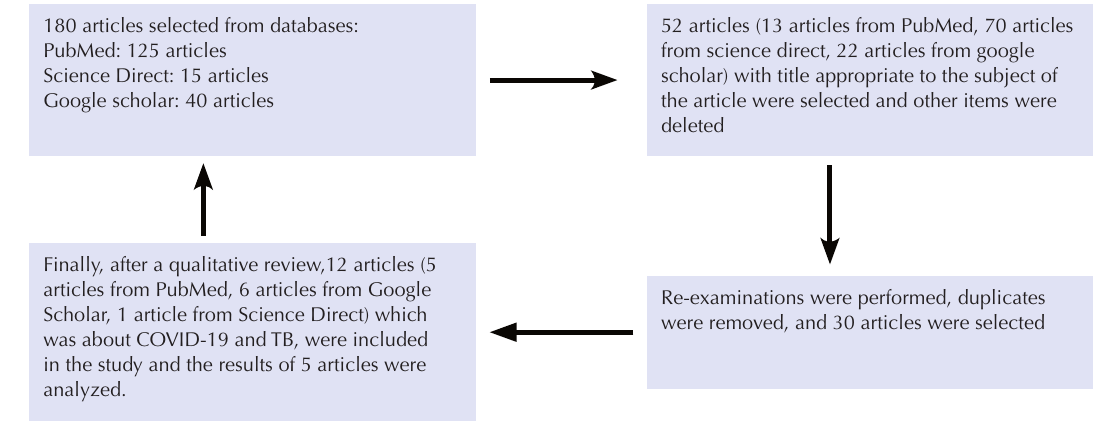
Figure 1. Summary of search strategy and paper